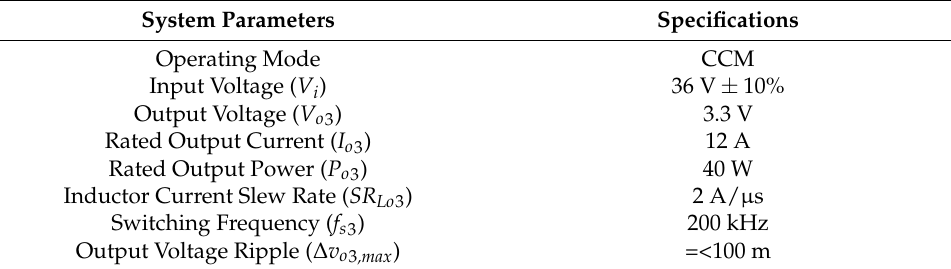
Table 3. Second secondary output